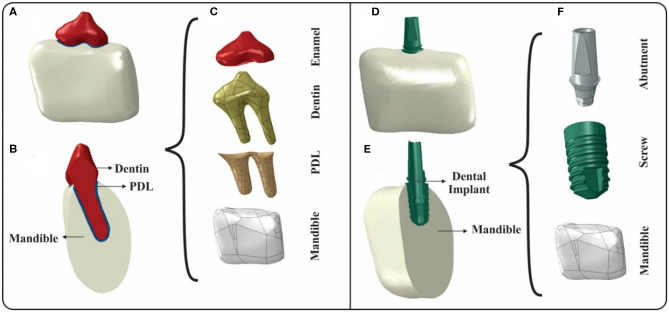
Generation of intact and implanted FE models: (A) Assembly of the tooth-PDL-mandible (T-PDL-M) construct in Abaqus software; (B) Cross-sectional view of T-PDL-M construct; (C) Constituents of T-PDL-M construct used to assemble the intact model; (D) Assembly of the dental implant-mandible (DI-M) construct in Abaqus software; (E) Cross-sectional view of DI-M construct; and (F) Constituents of DI-M construct used to assemble the implanted model.